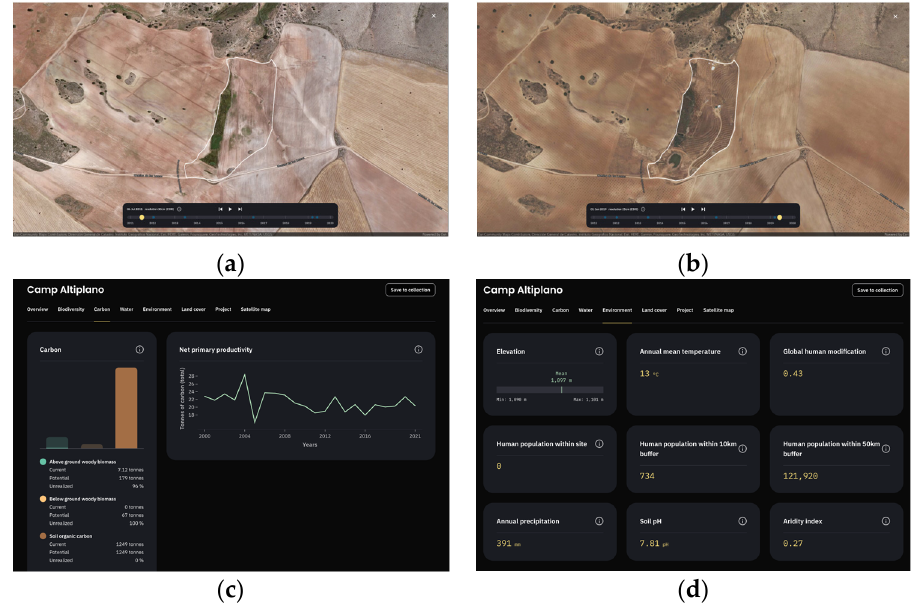
Figure 19. The Restor platform interface, in the specificity of ERC Camp Altiplano site (defined by white boundaries): the timeline before and after restoration ( a ) year 2012 and ( b ) the implemented information in the platform concerning ( c ) carbon and net primary productivity (estimated based on [18]) and ( d ) environmental data monitoring.